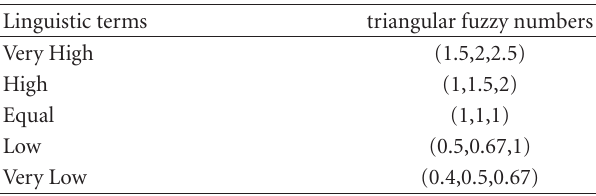
Table 5: Fuzzy comparison measures.